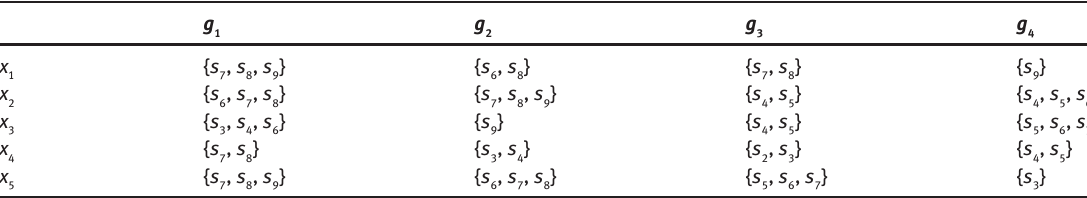
Table 3: Decision Matrix H (3)